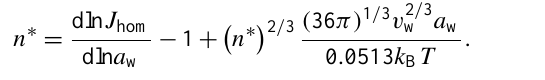
Figure 5. Critical germ size, n ∗ calculated at T f with D p = 10µm and 1t = 10s. Lines labeled as empirical were obtained using the K00 correlation and a form of the nucleation theorem (Kashchiev, 2000). CNT results were obtained using σ iw from the Turnbull (1950) correlation, (CNT-TUR, Eq. 25), an empirical correlation derived from fitting CNT to the K00 parameterization (CNT-EMP, Eq. 29), and a theoretical expression derived from the NNF model (CNT-NNF, Eq. 27). Results using the NNF model (Eq. 17) are also